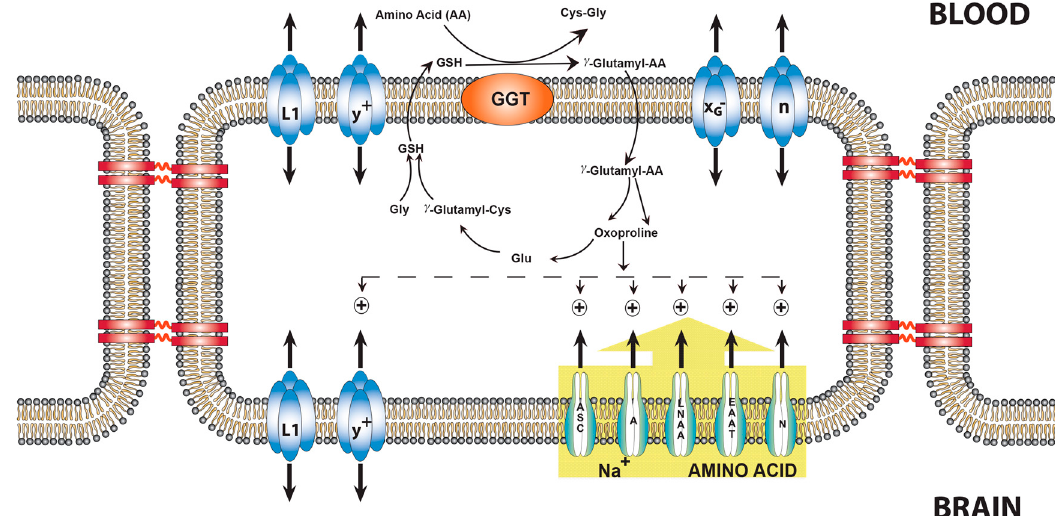
Figure 3. The influence of oxoproline on AA transport across the blood–brain barrier. γ -Glutamyl-AAs are formed at the outer surface of the luminal membranes of the endothelial cells that transfer the γ -glutamyl moiety of glutathione to most AA, thereby forming a γ -glutamyl-AA. The γ -glutamyl-AA enters endothelial cells, where the AA is released and oxoproline is formed. The Na + -dependent transport systems A, ASC, Na + -LNAA, EAAT, and y + , all located on the abluminal side, are activated by oxoproline [49]. System N was the only system not stimulated. L1 is present on both the luminal and abluminal membrane and is not affected by oxoproline [47]. Abbreviations: A, Na + -dependent system A; N, Na + -dependent system N; EAAT, Na + -dependent glutamate transporter, X G − , facilitative glutamate transporter, n, facilitative glutamine transporter. The possibility exists that oxoproline causes an increase in the transmembrane potential, therefore providing a greater driving force. All transport systems indicated by a + above them are stimulated by oxoproline.This illustration is modified from a figure in [19].